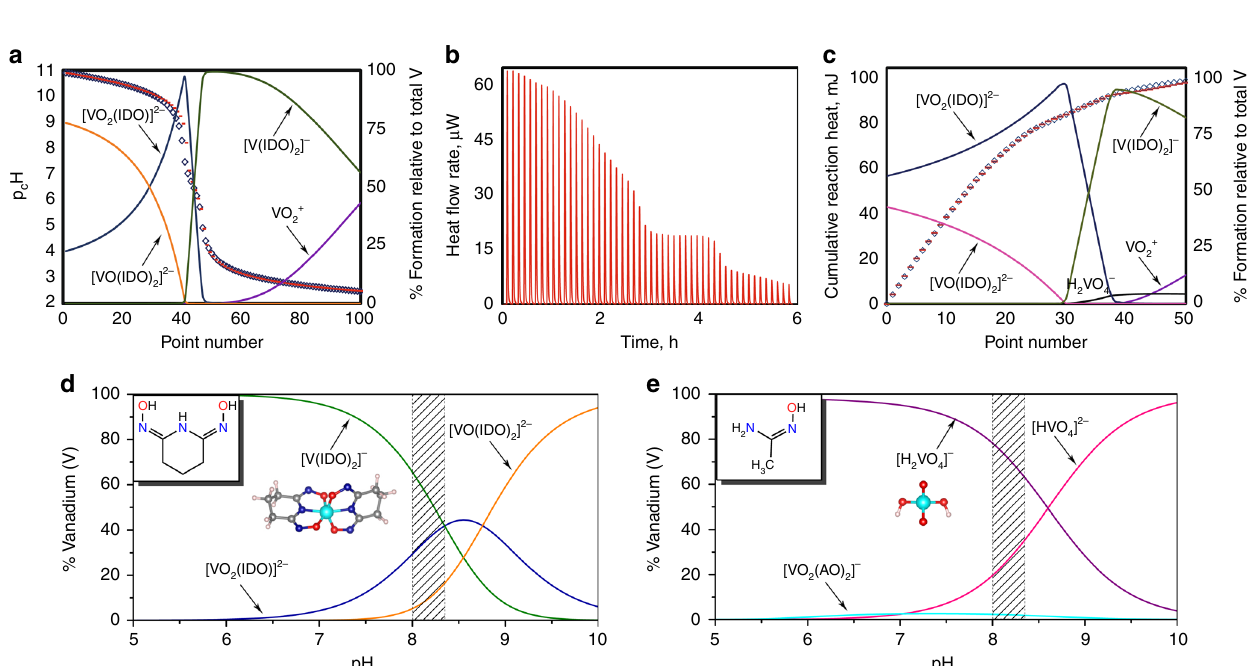
Fig. 3 Potentiometric and calorimetric titrations along with V(V) speciation diagrams under seawater conditions. a Potentiometric titration for the complexation of vanadium with H 3 IDO at 25 °C and I = 0.5 M (NaCl); observed (diamonds) and calculated ( − ) pH (left axis) with corresponding speciation (right axis); titration conditions: V o = 20.2 mL, [V] = 1.01 mM, [H 3 IDO] = 10.3 mM, [H] = 0.0129 M, titrant: 0.100 M HCl. b Calorimetric titration thermogram showing heat fl ow rate after each injection. c Cumulative observed (diamonds) and calculated ( − ) heats (left axis) with corresponding speciation (right axis) per injection; titration conditions: V o = 0.750mL, [V] = 1.0 mM, [H 3 IDO] = 4.16 mM, [H] = 3.32 mM; titrant: 0.020 M HCl; 5 μ L per injection. d Speciation of vanadium under seawater conditions with H 3 IDO and e HAO ligands; [V] = 3.6 × 10 − 8 M, [H 3 IDO] = 0.5 M, [HAO] = 0.5 M. Structures of prevalent species at the seawater pH are visualized for